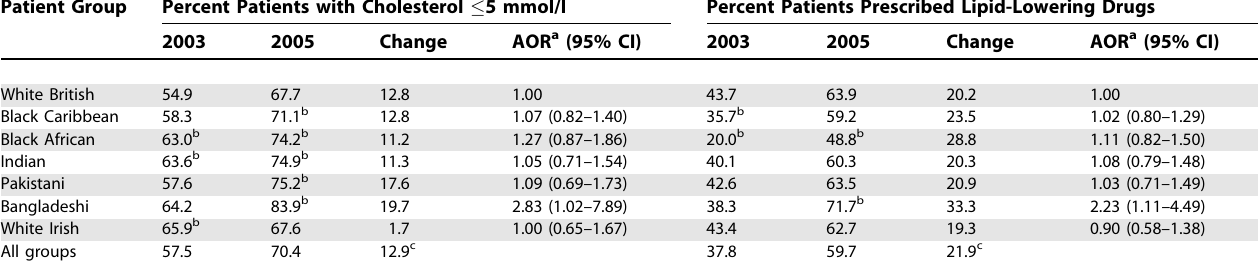
Table 2. Ethnic Disparities in Cholesterol Management and Control Patient